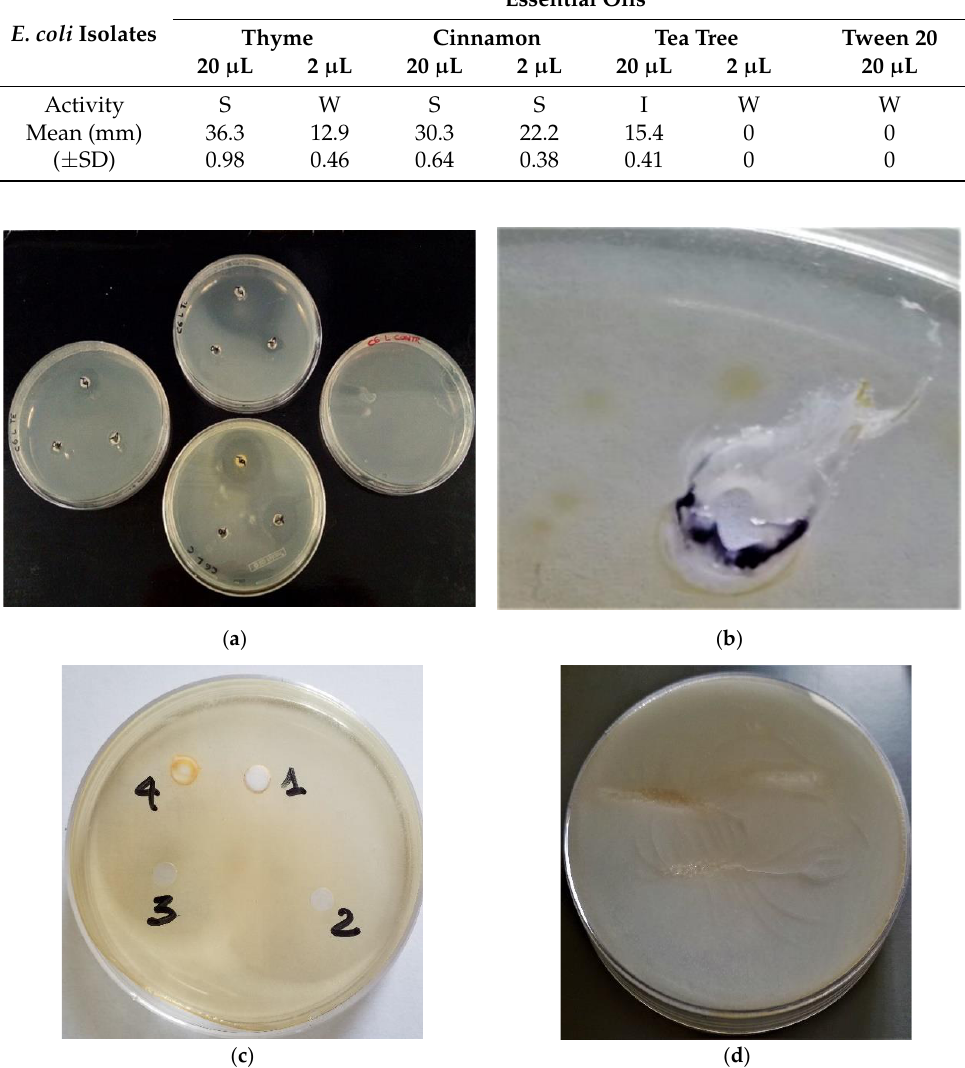
Figure 7. Example of EOs ’ aromatograms on sensitivity/resistance of E. coli isolated strains on Petri dishes ( a ); Alteration on plastic material on Petri dish surface after 48 h by addition of 20 µL of cinnamon EO ( b ); Comparison test on Petri dish between same amount (20 µL) of benzaldehyde (1), formaldehyde (2), formamide (3), and cinnamon EO (4) ( c ); Alteration of the plastic material of the lid of a Petri dish after adding 1 mL of cinnamon EO ( d ).